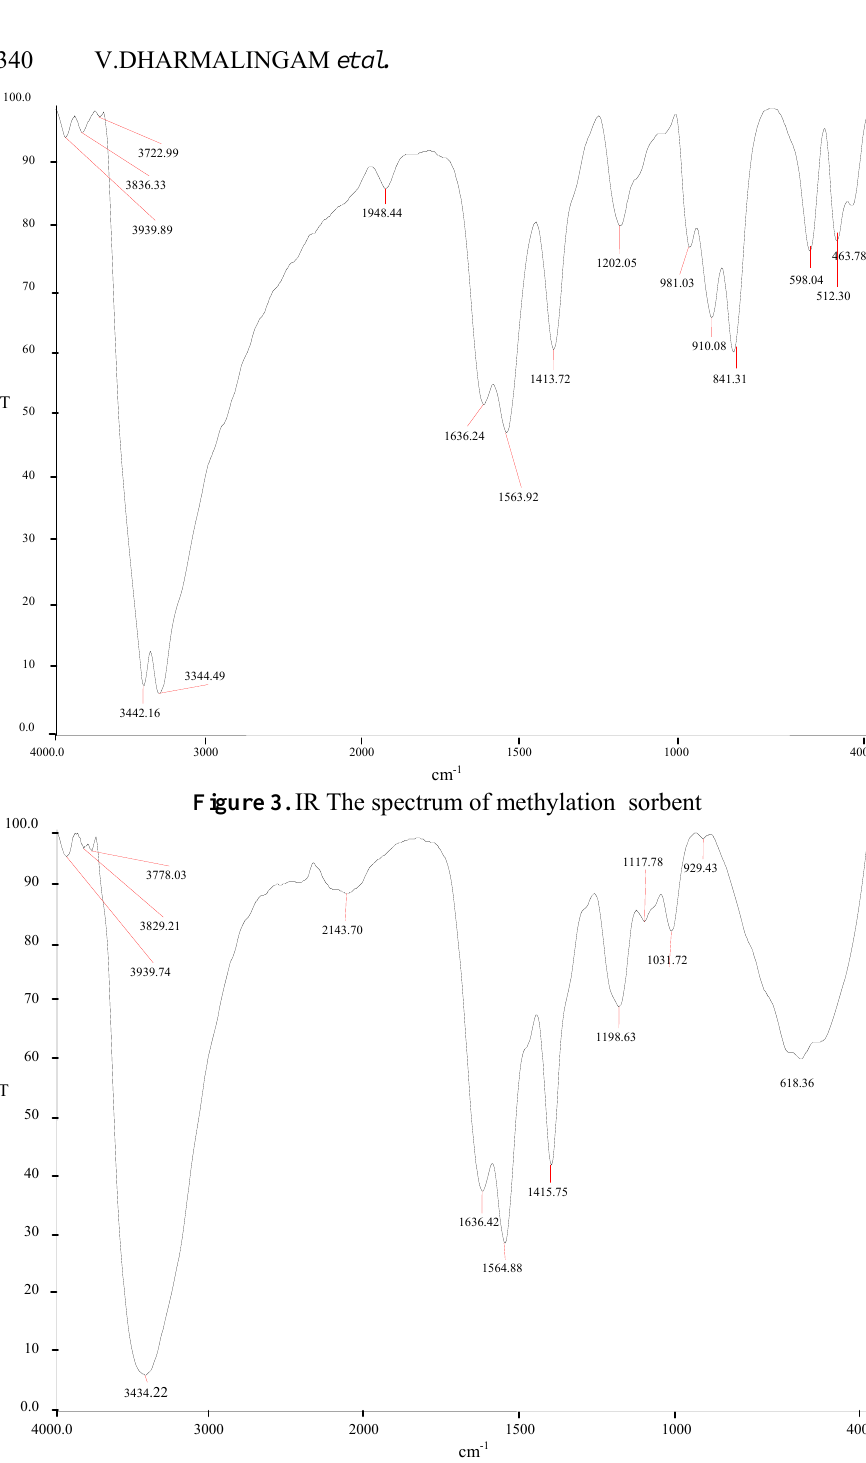
Figure 4. The IR spectrum of esterification